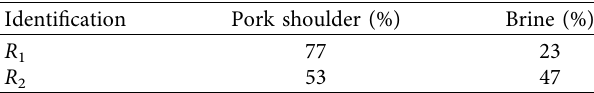
Table 2: Meat emulsion recipes